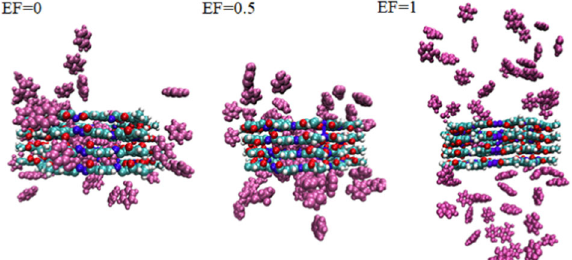
Fig. 1 The fi nal snapshots of the phenol-COFs complexes under different electrical fi elds. Water molecules and ions are not shown for clarity.